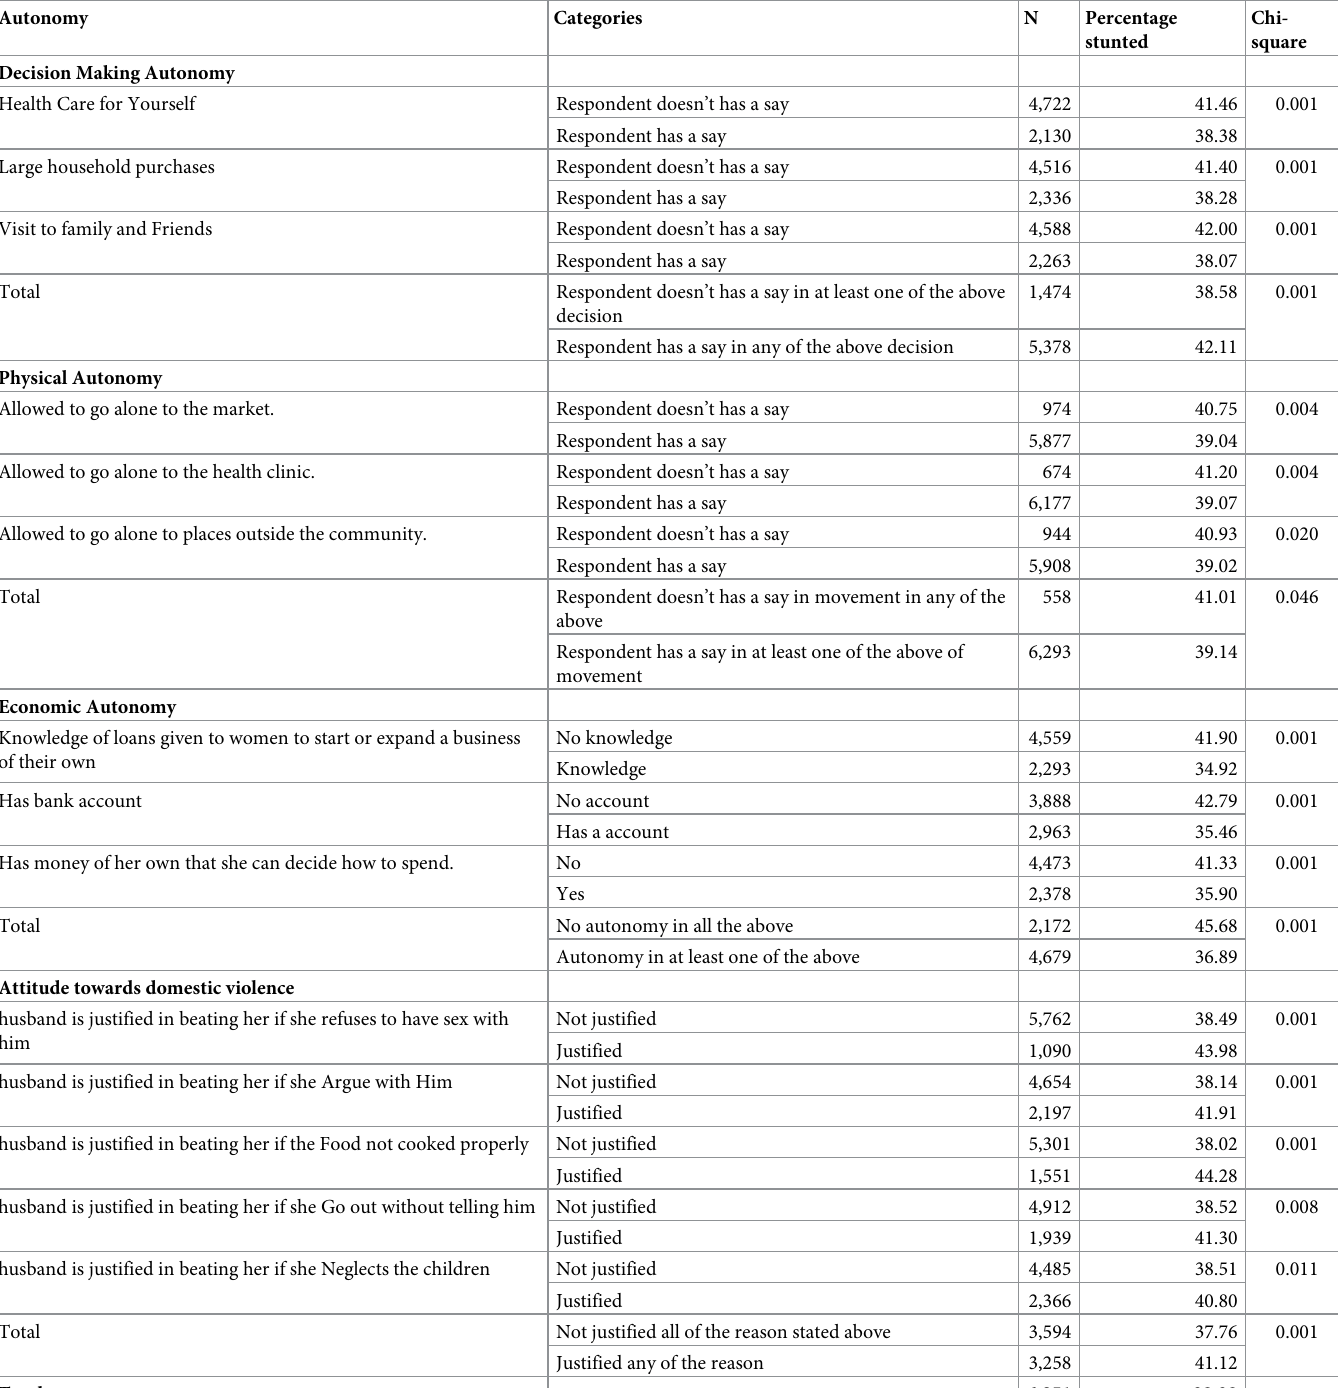
Table 3. Bivariate analysis of autonomy variables by stunting in India, NFHS-4,